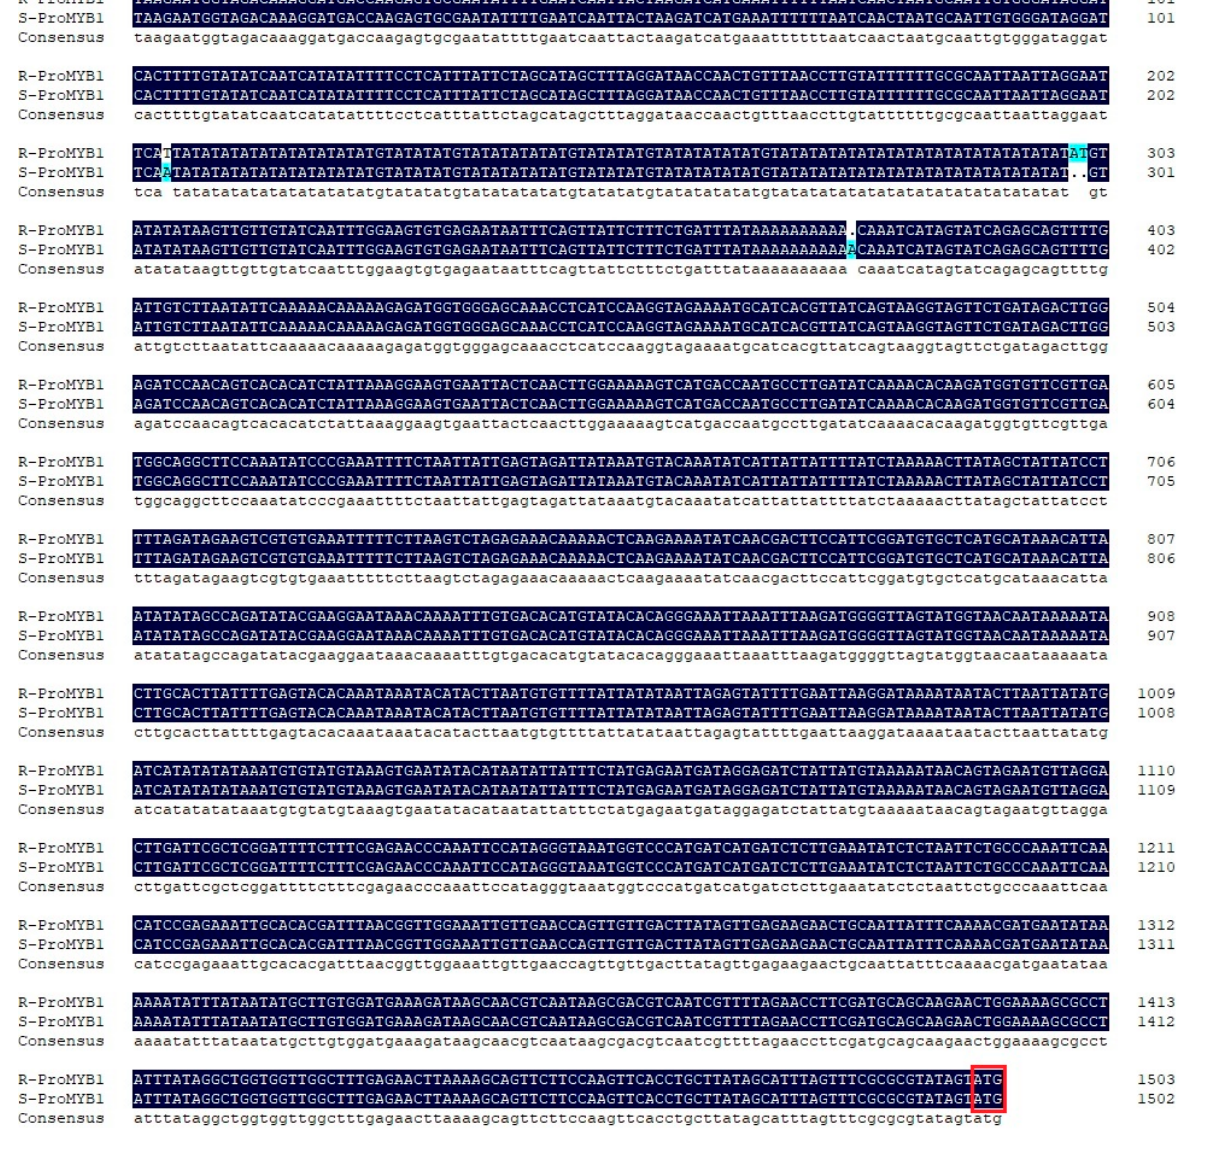
Figure 5. Sequence comparison of MiMYB1 promoter between ‘Ruby’ and ‘Sensation’.